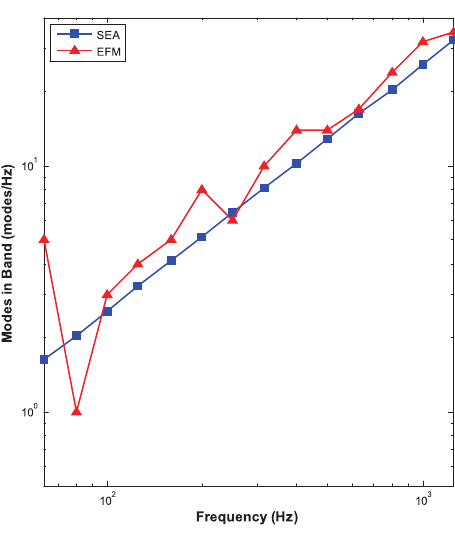
Fig. 7. Mode shapes of five plate model.